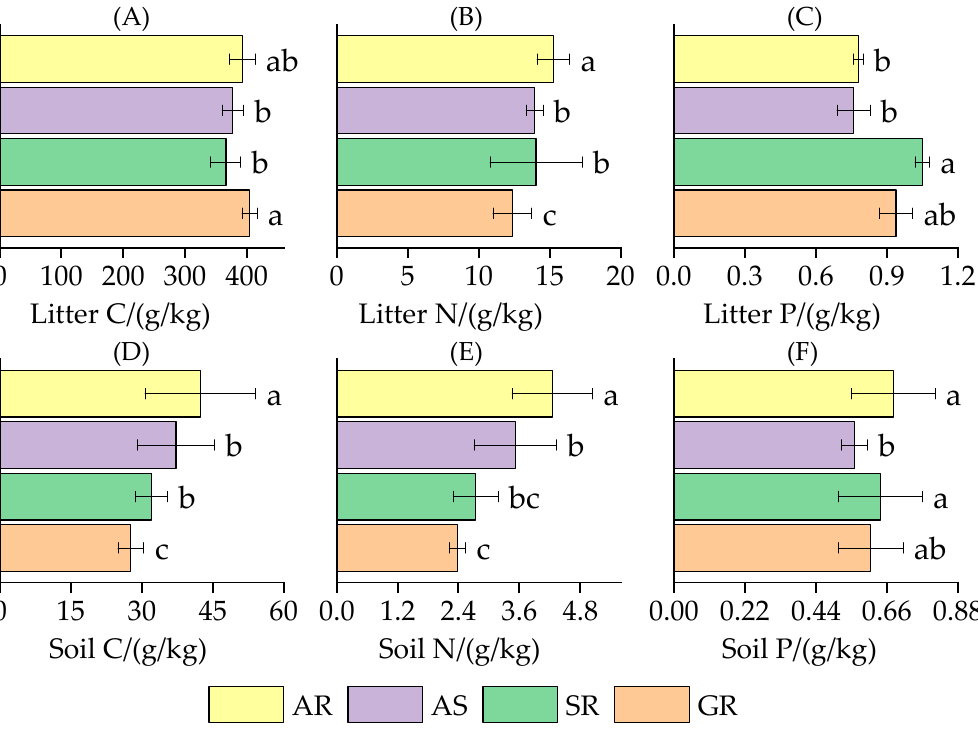
Figure 2. The carbo, nitrogen, and phosphorus content of litter and soil in different vegetation types. Note: Subfigure ( A ) = litter carbon content in different vegetation types, subfigure ( B ) = litter nitrogen content in different vegetation types, subfigure ( C ) = litter phosphorus content in different vegetation types, subfigure ( D ) = soil organic carbon content in different vegetation types, subfigure ( E ) = soil nitrogen content in different vegetation types, and subfigure ( F ) = soil phosphorus content in different vegetation types. GR = grassland, SR = shrubland, AS = arbor and shrub compound forest, and AR = arbor forest. The error bar shows the standard deviation of the average. Different lowercase letters indicate significant differences at the 0.05 level ( p < 0.05) between different vegetation types.